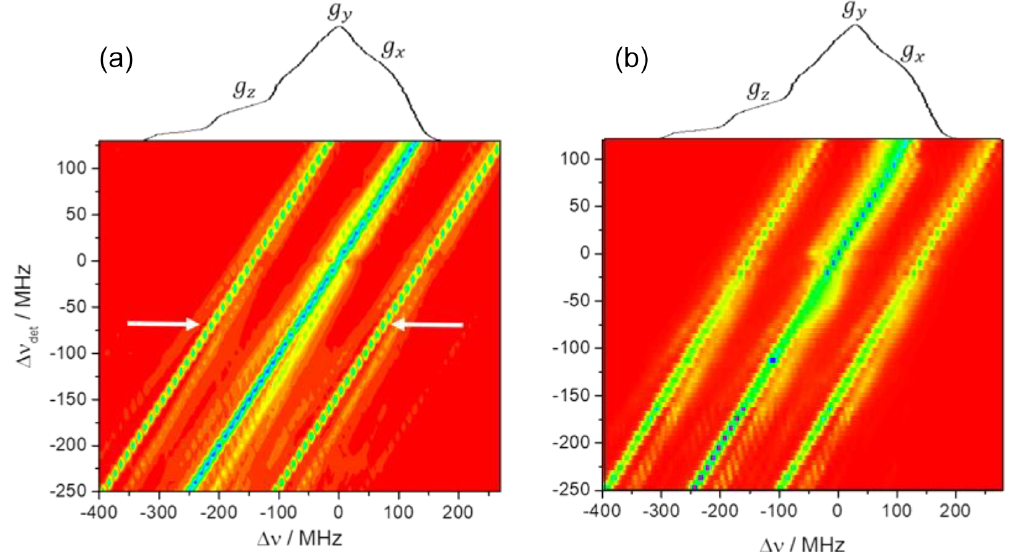
Figure 4. 2D contour ELDOR spectra of the 0.5mM sample (a) experimental (20K) and (b) simulated spectra, where the y axis is the off-resonance detection frequency ( (cid:49)ν det = ν det − 94 . 8GHz) and the x axis is the off-resonance pump frequency ( (cid:49)ν ). The central diagonal line corresponds to the allowed EPR transitions while the intense parallel lines on both its sides correspond to 1 H signals as indicated by white arrows in the experimental spectrum. The weaker lines around the center diagonal correspond to forbidden transitions involving 14 N and those about the outer 1 H lines are due to those involving both 1 H and 14